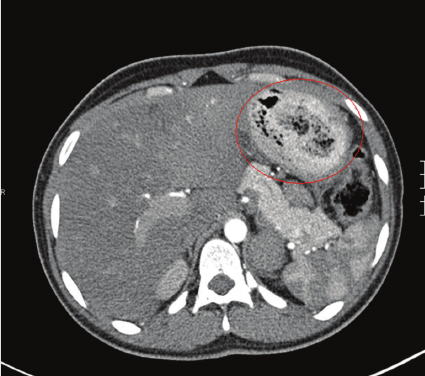
Figure 1: Computed tomography of the abdomen showing a tri- chobezoar located in the stomach (circled in red).